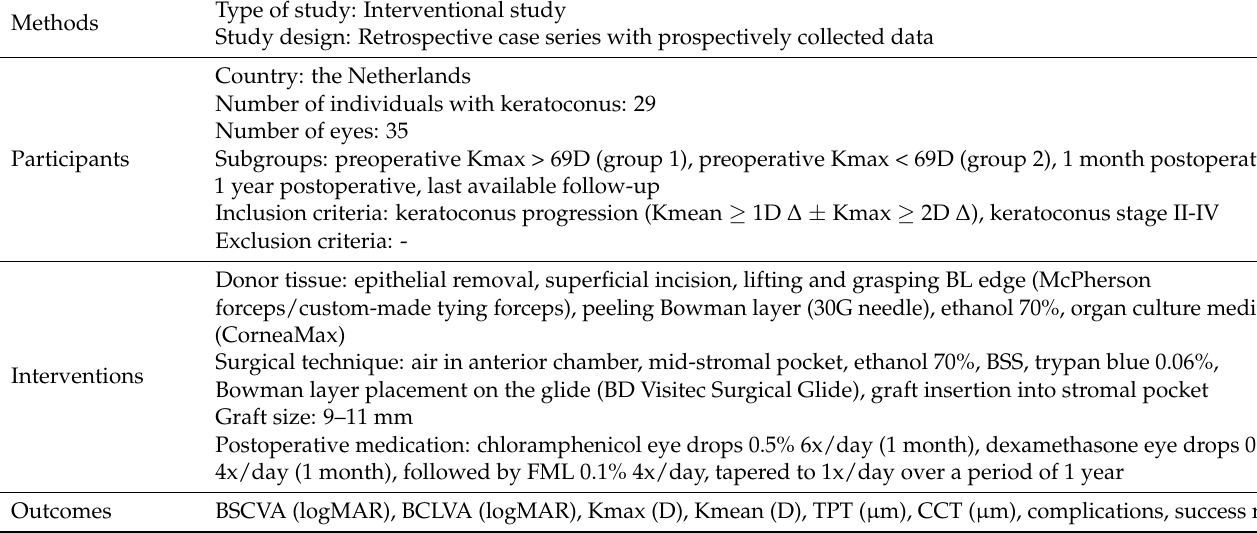
Table A13. Van Der Star 2022 [43].